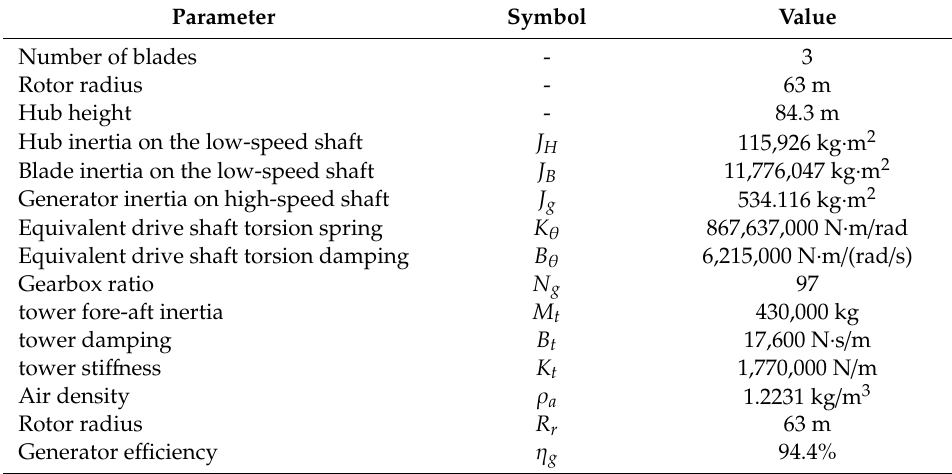
Table A1. The parameters in the 5-MW VSWT system.